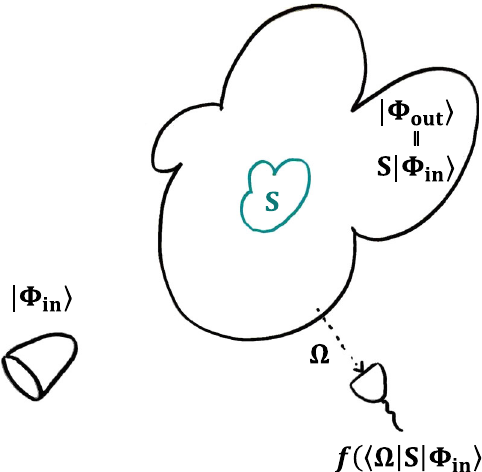
FIG. 1. Interaction in the Hilbert space of transverse Maxwell fields. An incident field j Φ interacts with an object, charac- in i terized by its interaction operator S , and produces a scattered field j Φ out i ¼ S j Φ in i . A detector like the one in the bottom right corner of the figure obtains information about the field scattered through f ðh Ω j S j Φ the solid angle Ω : f ðh Ω j Φ , where h Ψ j Γ i is out iÞ ¼ in iÞ the scalar product of the two vectors j Ψ i and j Γ i . The interaction operator S also describes absorption and near-field illumination and/or